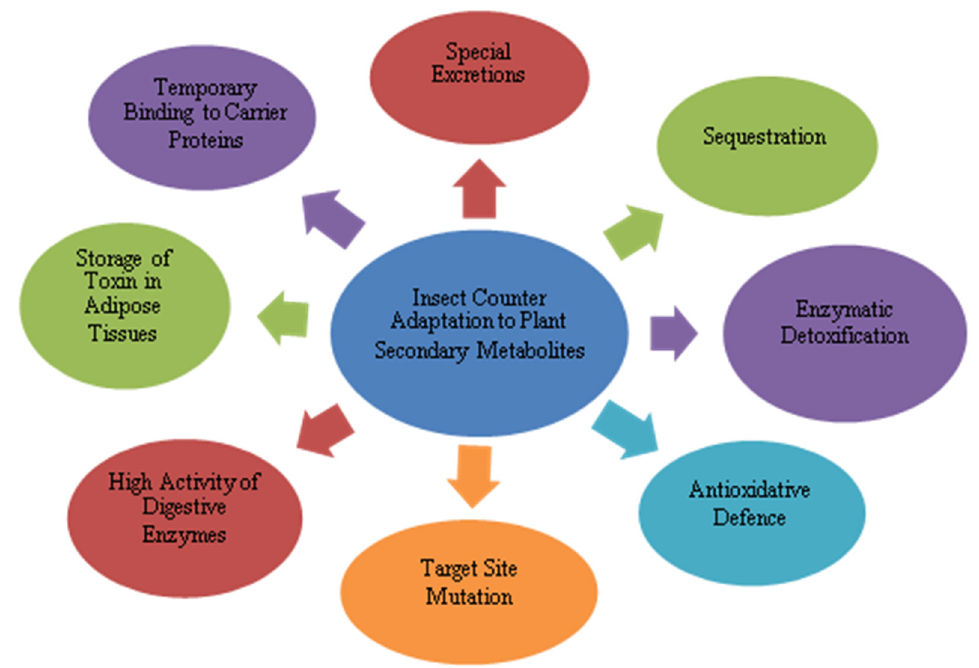
Figure 4. Insect Counter Adaptation to Plant Secondary Metabolites.